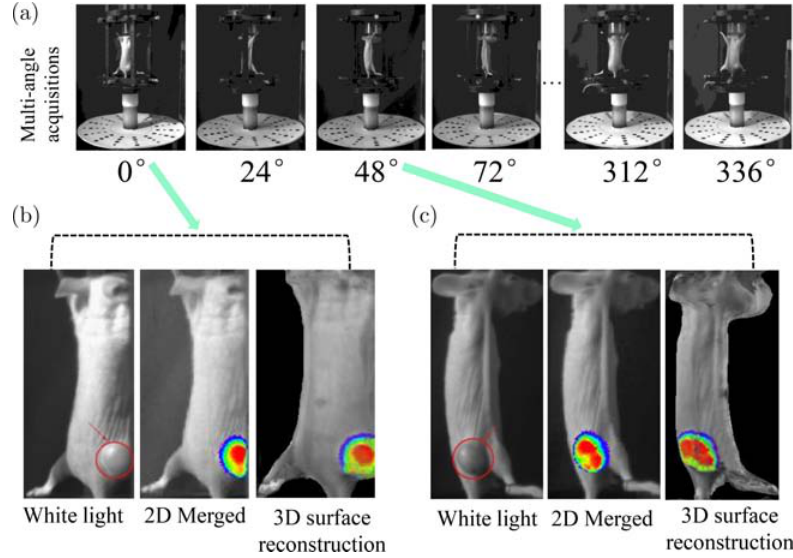
Fig. 3. Results of the multi-view imaging acquisition and the 3D surface generation. (a) The sequential 2D white-light images of a tumor bearing mouse model was acquired in di®erent projection angles. (b) The examples of the planar white-light image, the planar bioluminescent and white-light merged image, and the 3D surface reconstruction are demonstrated from left to right. The red circle and arrow indicate the location of the tumor. (c) Another example of the same arrangement as (b) at 48 (cid:6) . The 3D surface reconstruction in both (b) and (c) shows a good correlation in shapes with the corresponding 2D merged